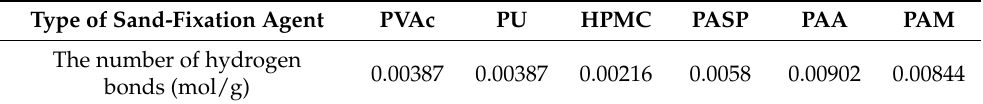
Table 3. The number of hydrogen bonds per unit molecular weight. Type of Sand-Fixation Agent PVAc PU HPMC The number of hydrogen bonds